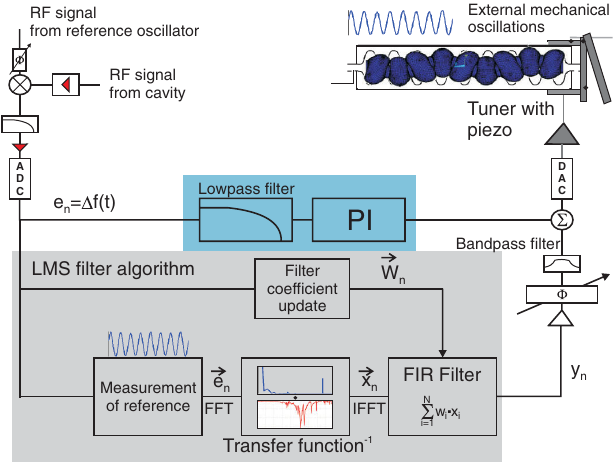
FIG. 14. (Color) The complete microphonics detuning compen- sation scheme given by a feedback (blue) and an adaptive feedforward signal path